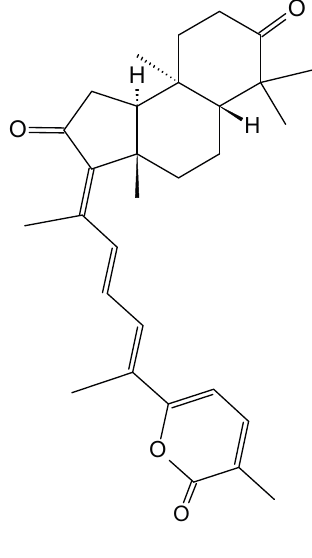
Figure 44. Stellettin A ( 128